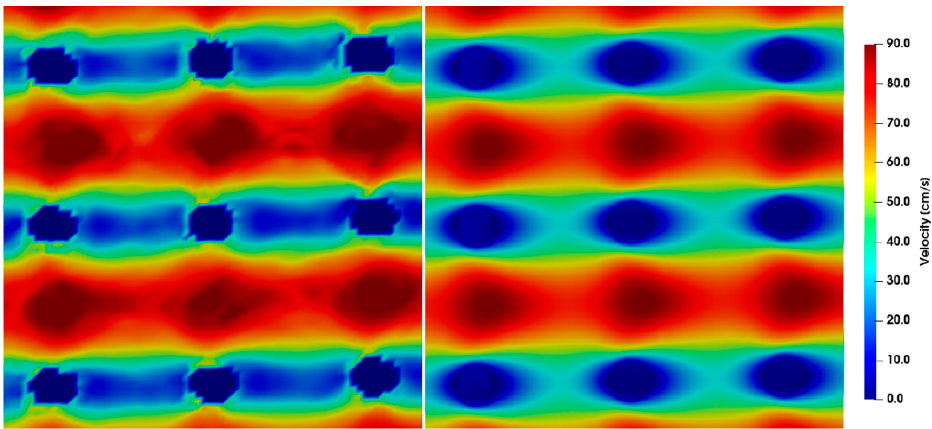
Figure 9. Microparticle image velocimetry (µPIV) measurements ( left ) compared to simulations ( right ) showing the velocity field around posts at Re = 7.62. The direction of flow is from left to right, the pitch between the posts is 20 µm at a time difference between double frames of dt = 3 µs.